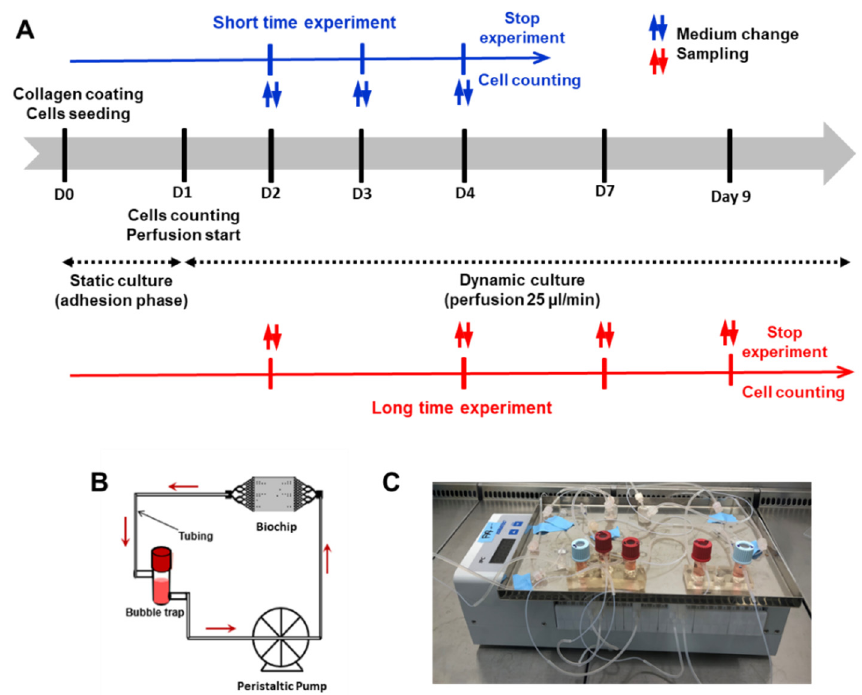
Figure 2. Design of the experiments: ( A ) Timing and steps of short and long-time experiments including the adhesion and perfusion phases, ( B , C ) schematic representation ad image of dynamic flow setup respectively.